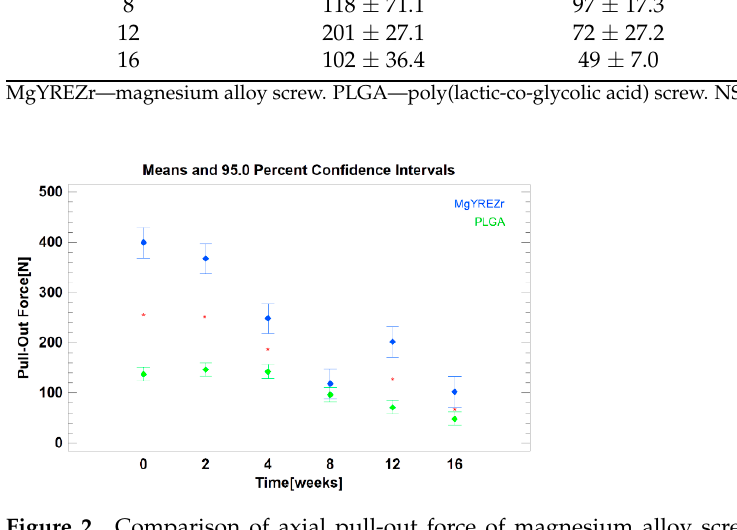
Table 1. Axial pull-out force change during screw material resorption (mean ± standard deviation).